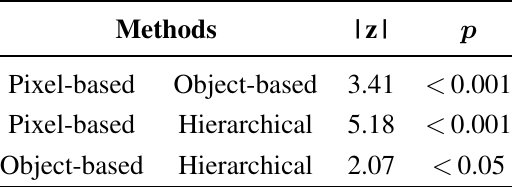
Table 6. Results of McNemar’s tests for the statistical significance of differences between the pixel-based, object-based, and hierarchical classification